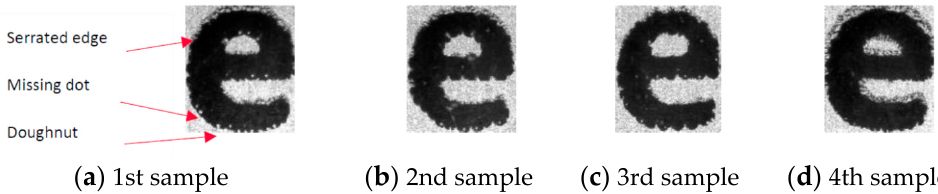
Figure 1. Examples of sample letters “e” printed (or reprinted) with: ( a ) an engraved cylinder and a rotogravure press, ( b ) same rotogravure press but using another engraved cylinder, ( c ) same engraved cylinder as in ( a ) but using another rotogravure press, ( d ) same engraved cylinder as in ( b ) and same rotogravure press as in ( c ).